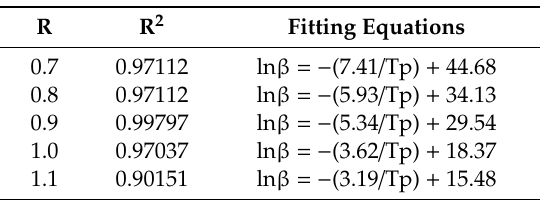
Figure 8. Crystallization activation energy (Ec) calculated using the Ozawa method. Table 6. The fitting equations and R 2 .